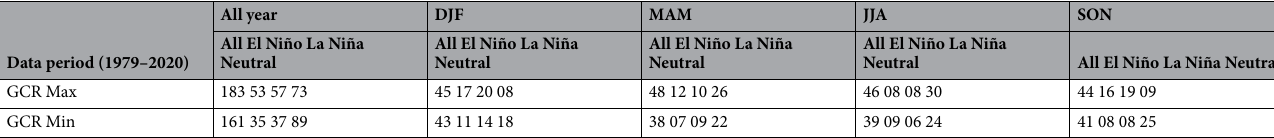
Table 2. All year and seasonal sampling in months belongs to each GCR Max and GCR Min groups during All, subdivided into El Niño, La Niña, and Neutral periods for the 42 years